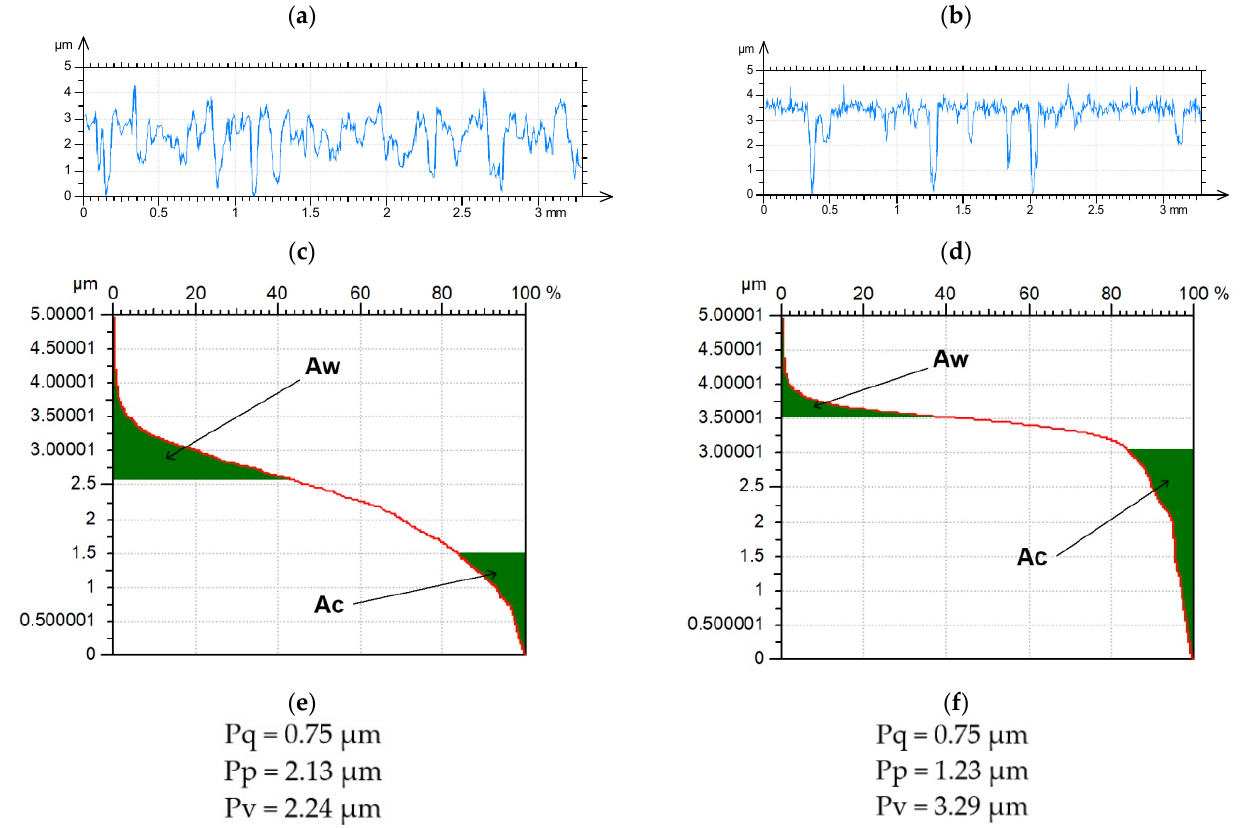
Figure 1. Profiles ( a , b ), material ratio curve ( c , d ) and parameters ( e , f ) of ( a , c , e ) one-process and ( b , d , f ) two-process surfaces.